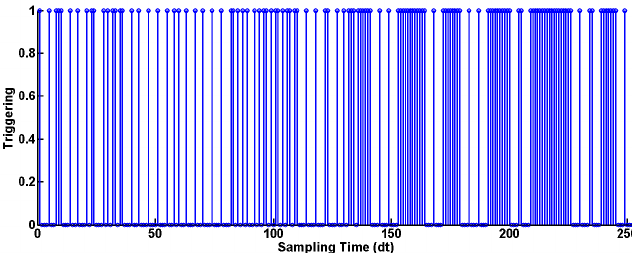
Figure 9. The triggering instants in Self triggered NMPC, c (cid:13) 2014 IEEE [58].